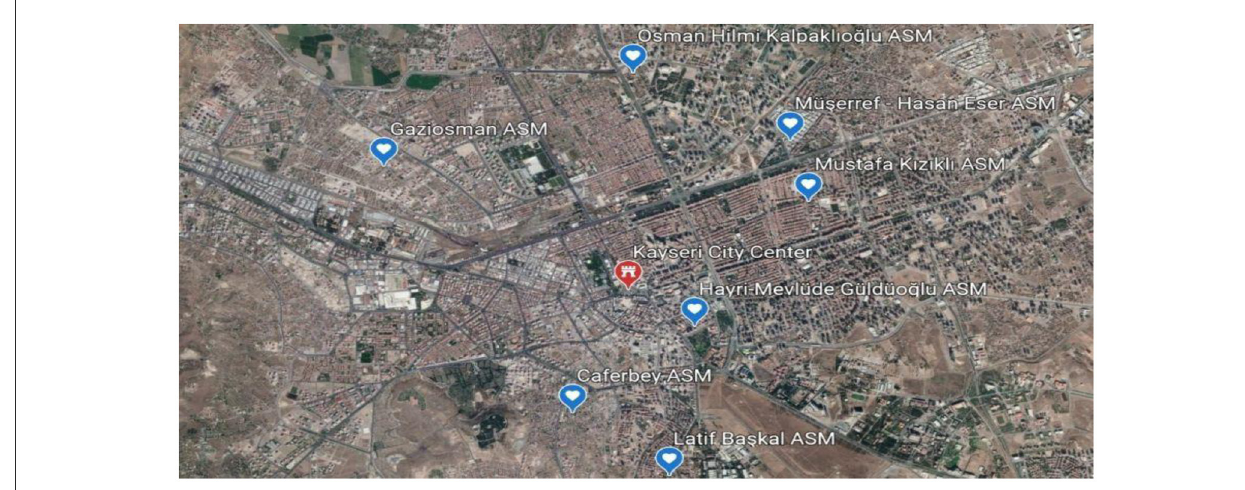
FIGURE1 The map of research regions in the years 2004 and 2017.